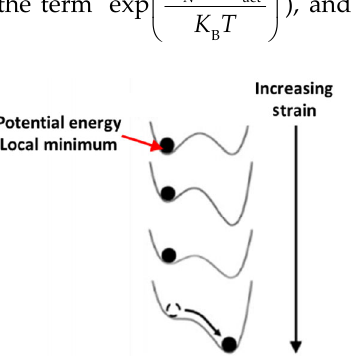
Fig. 5 Schematic of changes in the potential energy landscape with